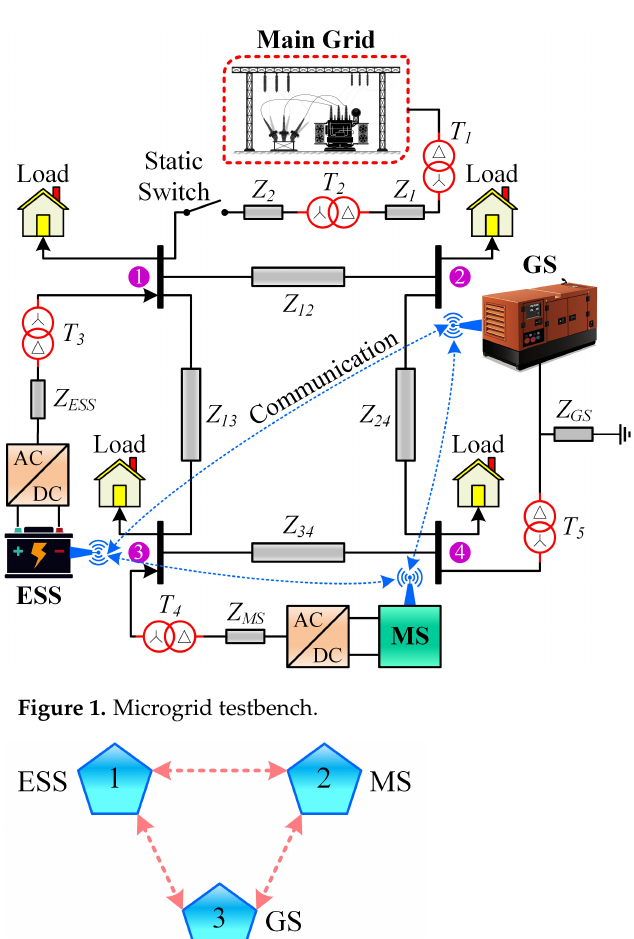
Figure 2. Communication